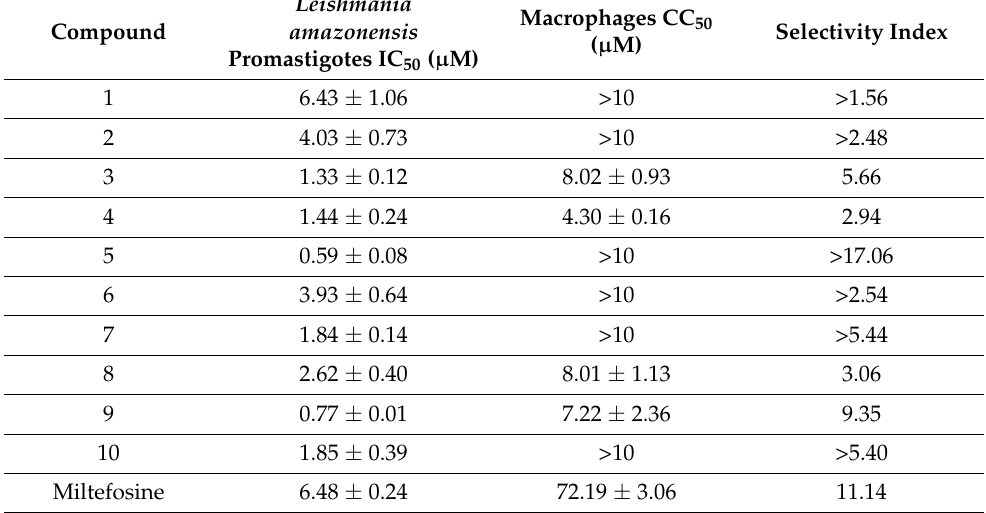
Table 1. Leishmanicidal activity against promastigote stage of the best compounds from MMV